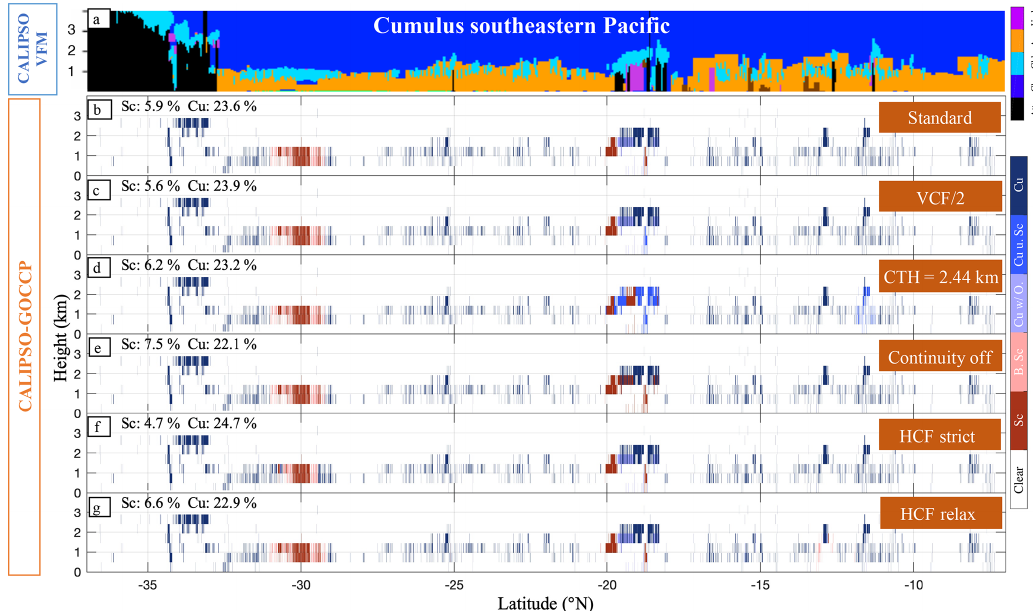
Figure 8. Same as Fig. 5 but for a typical cumulus case in the southeastern Pacific ( ∼ 37 to 8 ◦ S, 8 July 2008 21:47:30, daytime).